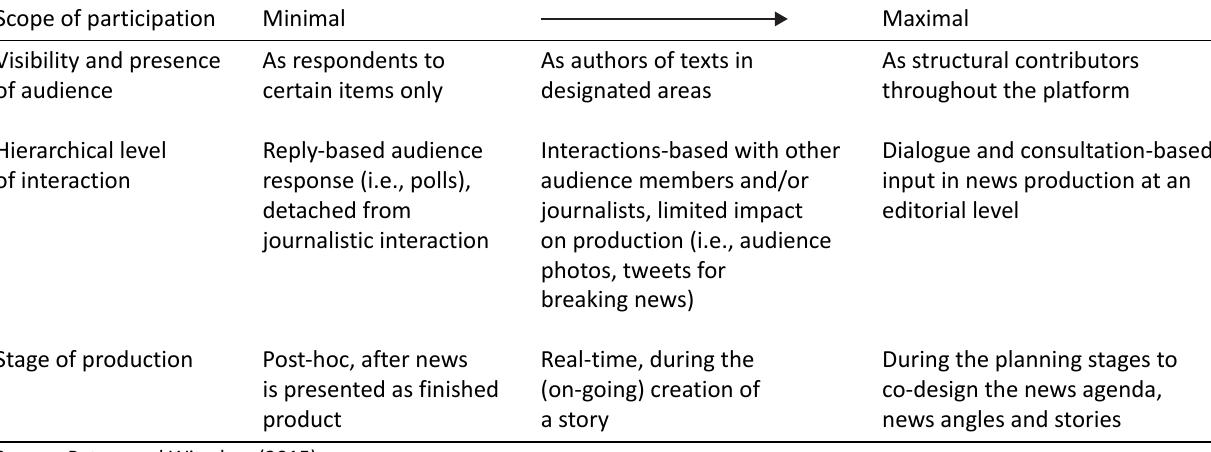
Table 1. Scope and degree of participation. Scope of participation Minimal Maximal Visibility and presence